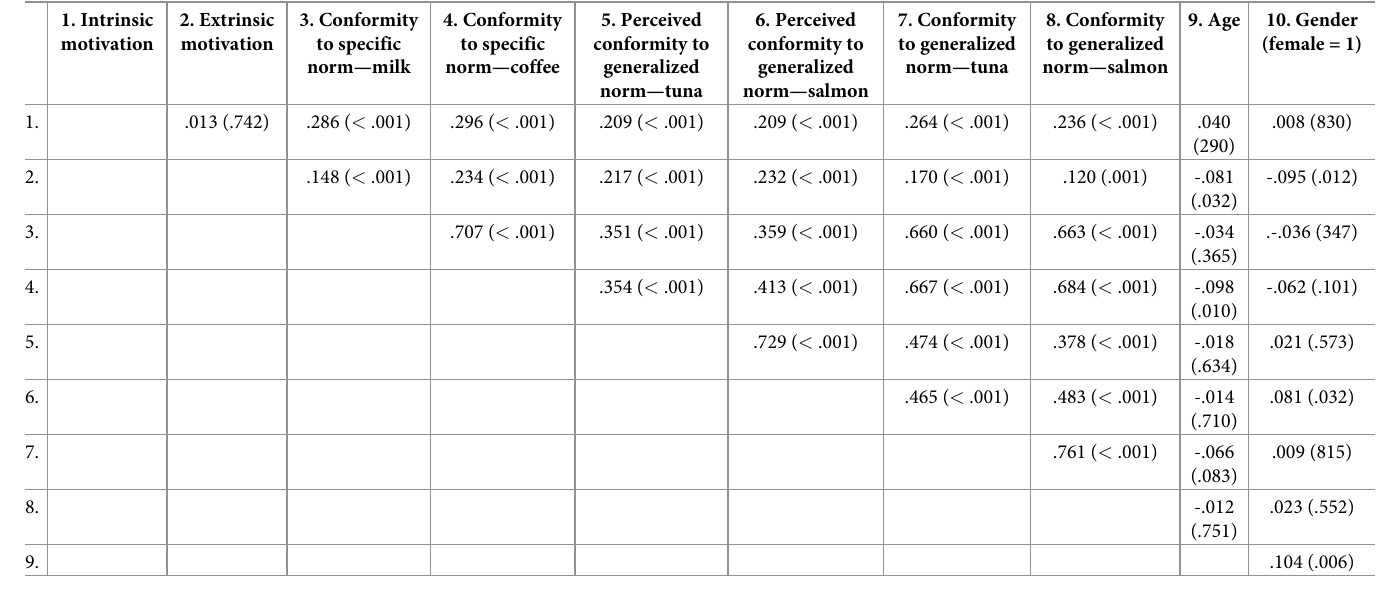
Table 4. Correlation table of all measured variables in Study